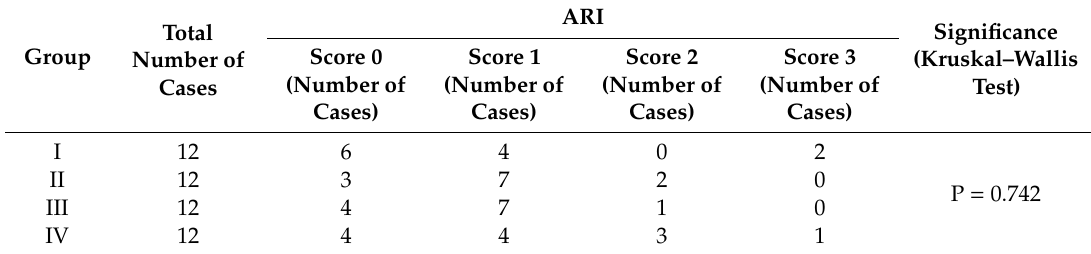
Table 3. Fracture modes after SBS